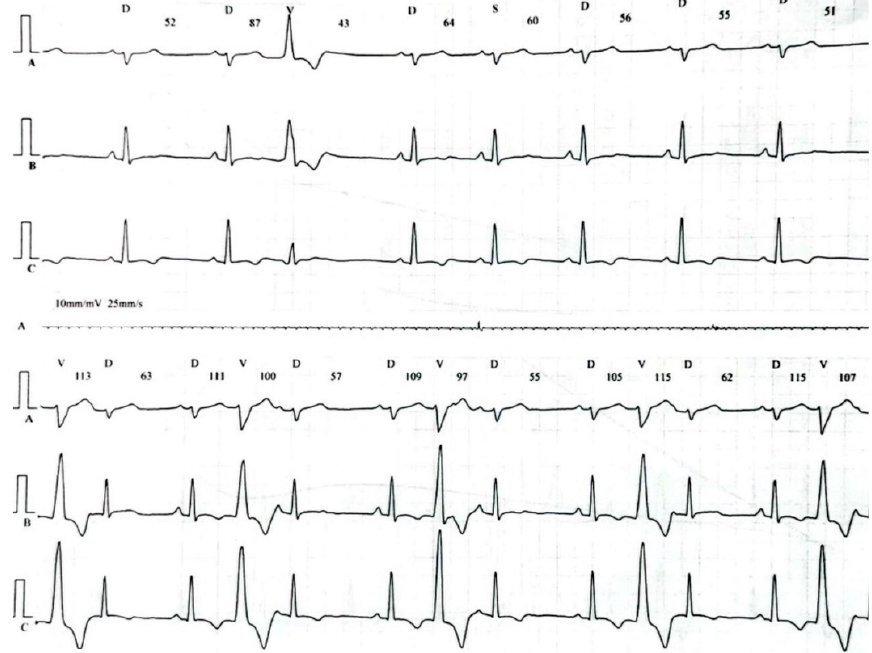
Figure 7. Excerpt from 24-h Holter monitoring of electrocardiogram. Sinus rhythm, additional ven- tricular beats with 2 different morphologies (single beats on top and concealed beats on bottom panel).